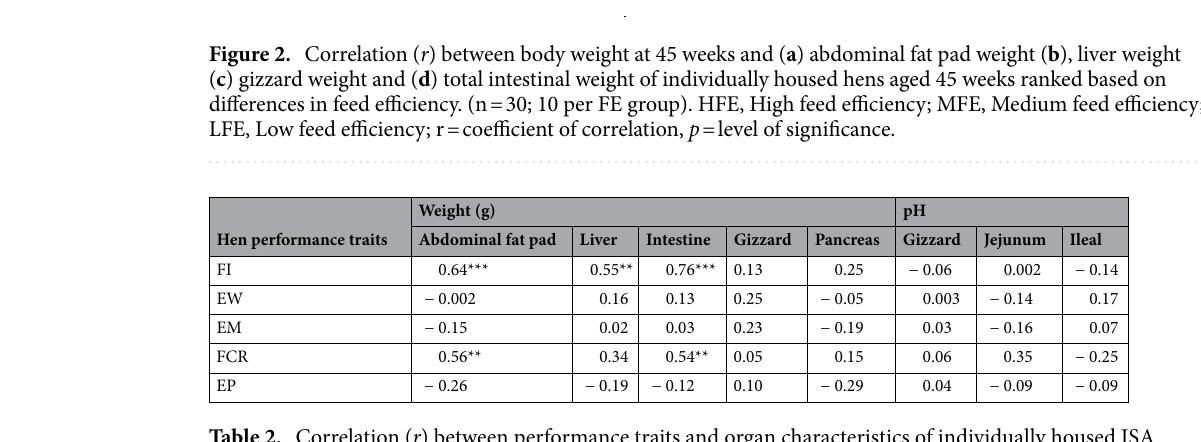
Table 2. Correlation ( r ) between performance traits and organ characteristics of individually housed ISA Brown hens aged 45 weeks. BWC, body weight change; FI, feed intake; EW, egg weight; EM, egg mass; FCR, feed conversion ratio; EP, egg production. *Coefficients with a superscript of * = p ≤ 0.05; ** = p < 0.01; *** = p < 0.001.